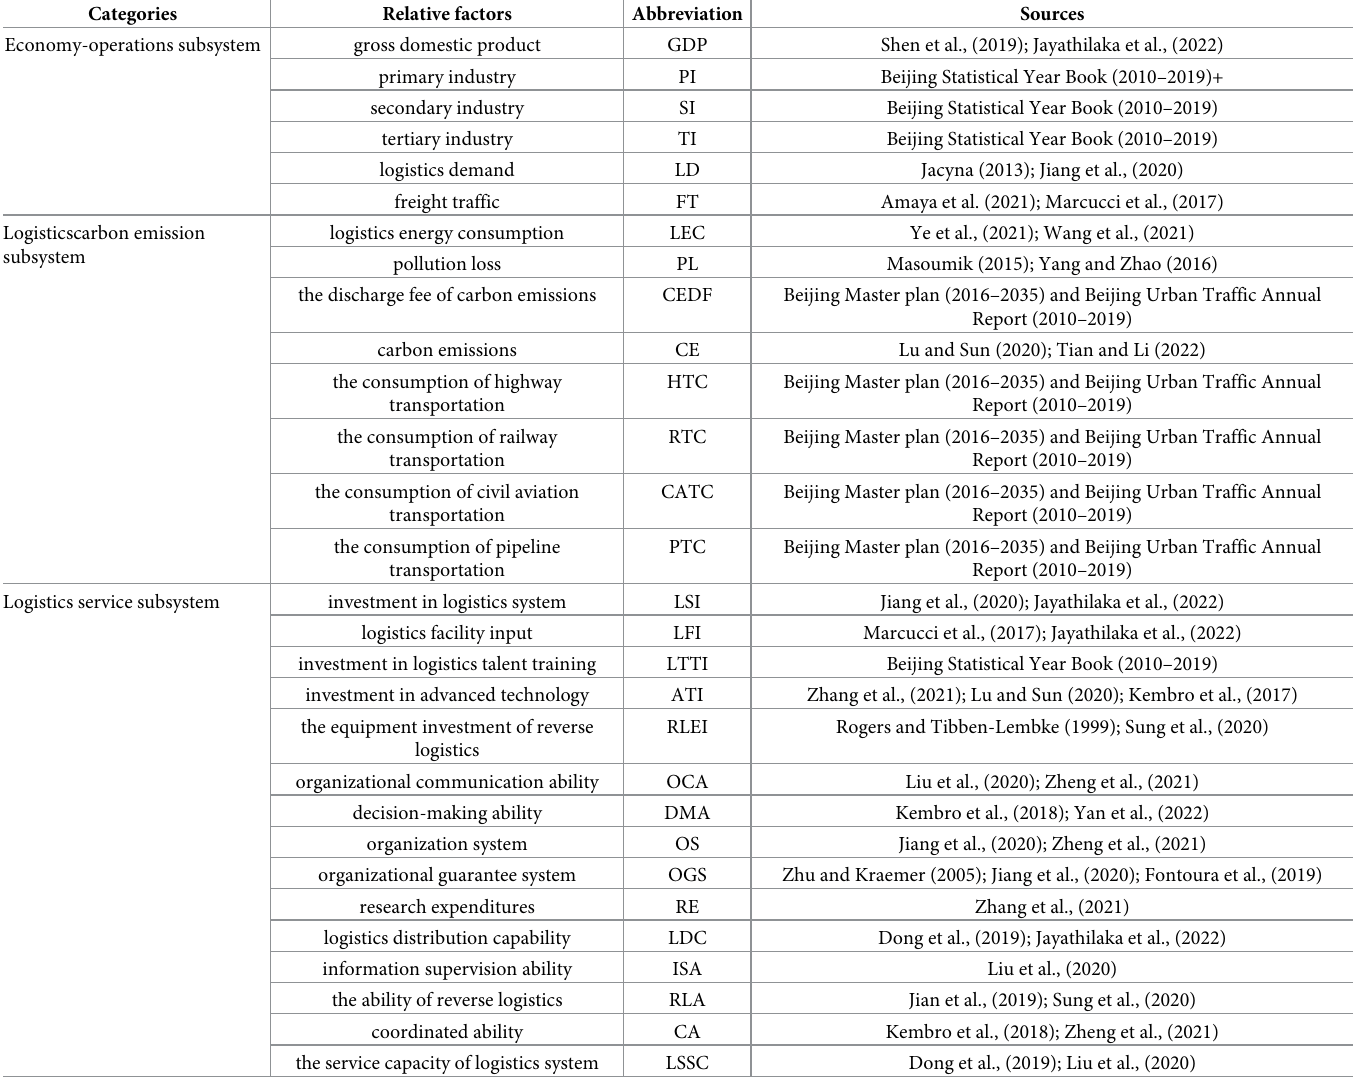
Table 2. Main factors and abbreviations of SD